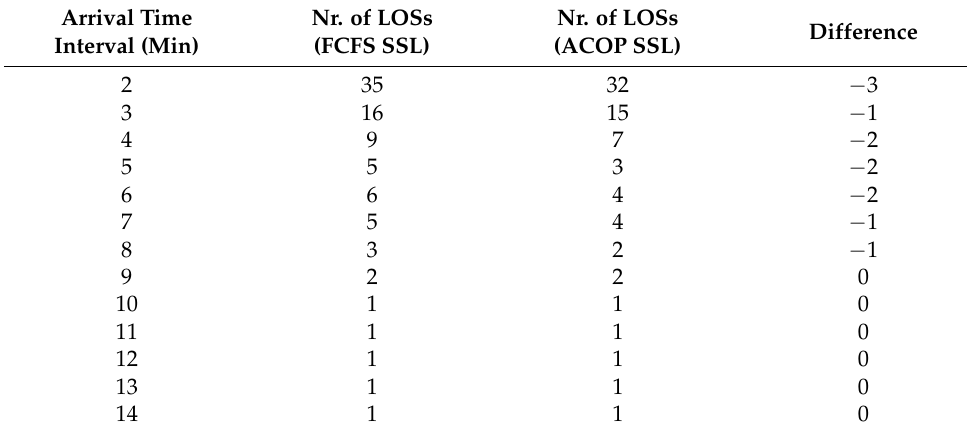
Table 2. Effect of the ACOP conflict reduction capability at SSL.